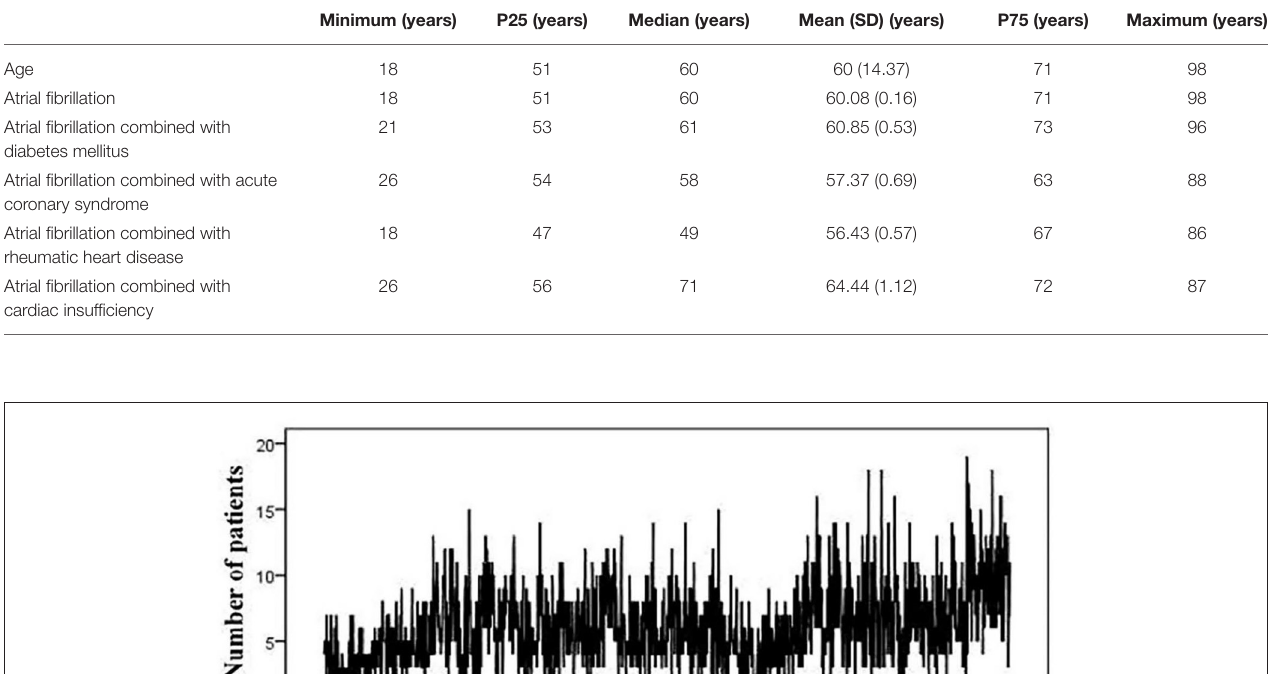
TABLE 3 | Statistical description of the general information of patients with atrial fibrillation visiting the Emergency Department in 2011–2014.